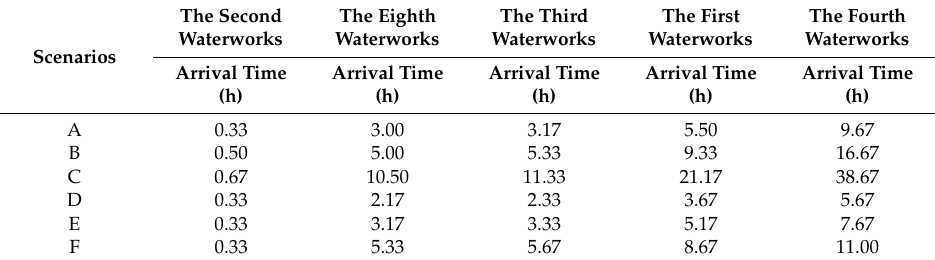
Table 2. Pollutant arrival time at the intakes of waterworks.